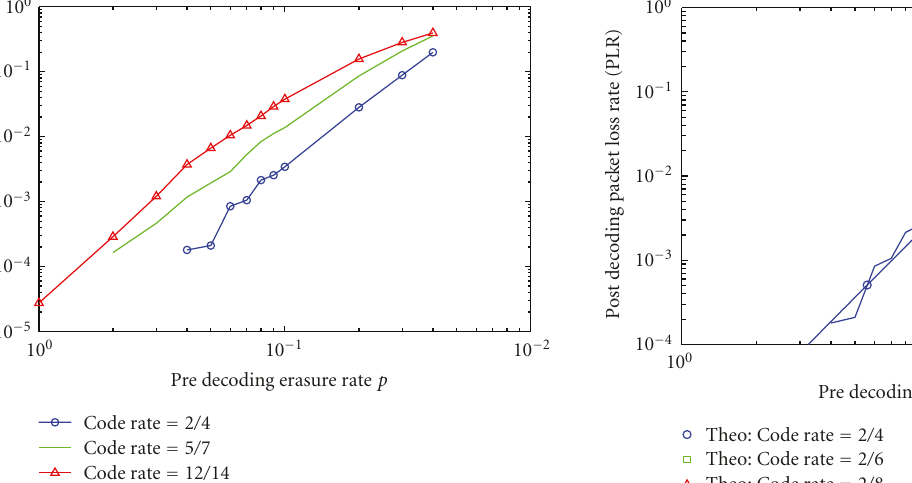
Figure 1: Packet loss rate for systematic codes with d min = 3.